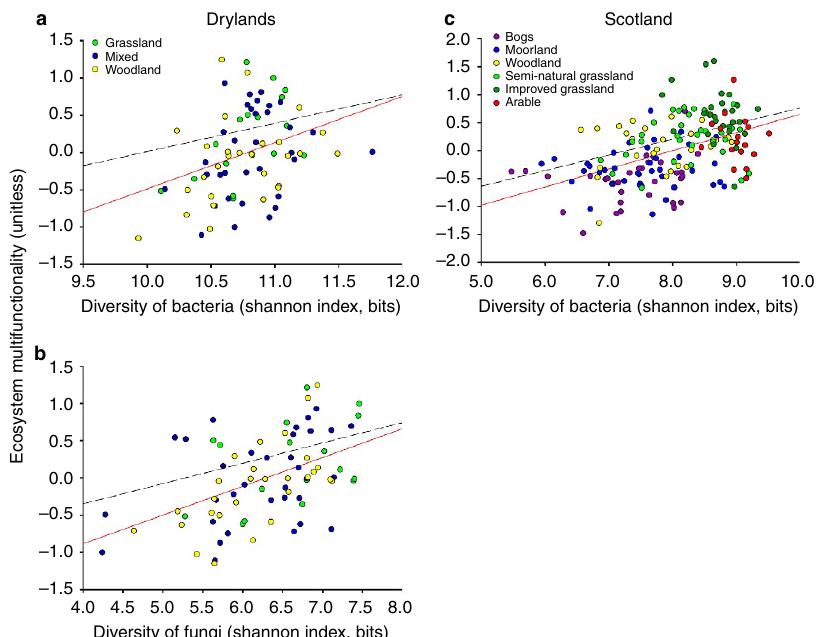
Figure 1 | Relationships between microbial diversity and ecosystem multifunctionality. Results are shown for the Drylands (bacteria ( a ) and fungi ( b )) and Scotland (bacteria ( c )) data sets. The solid and dashed lines represent the fitted ordinary least squares (OLS) and simultaneous autoregression (SAR) models, respectively. Results of regressions are as follows: ( a ) OLS, R 2 ¼ 0.118, P ¼ 0.012, AICc ¼ 133.463; SAR, R 2 ¼ 0.101, P ¼ 0.005, AICc ¼ 135.013; ( b ) OLS, R 2 ¼ 0.235, P ¼ 0.002, AICc ¼ 122.399; SAR, R 2 ¼ 0.215, P o 0.001, AICc ¼ 124.433 ( c ) OLS, R 2 ¼ 0.226, P o 0.001, AICc ¼ 265.539; SAR, R 2 ¼ 0.222, P o 0.001, AICc ¼